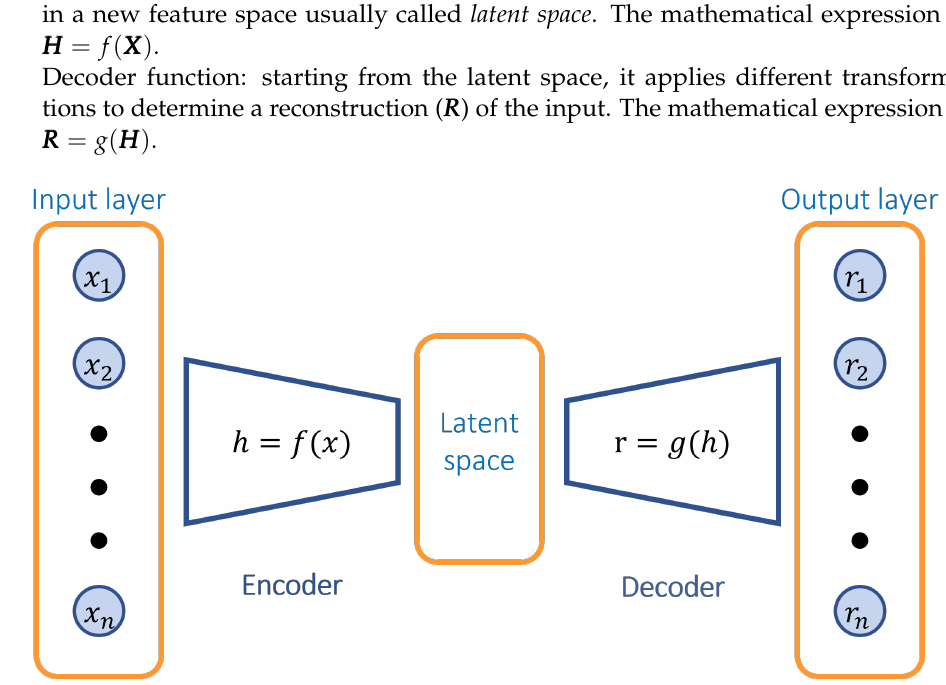
Figure 5. Autoencoder